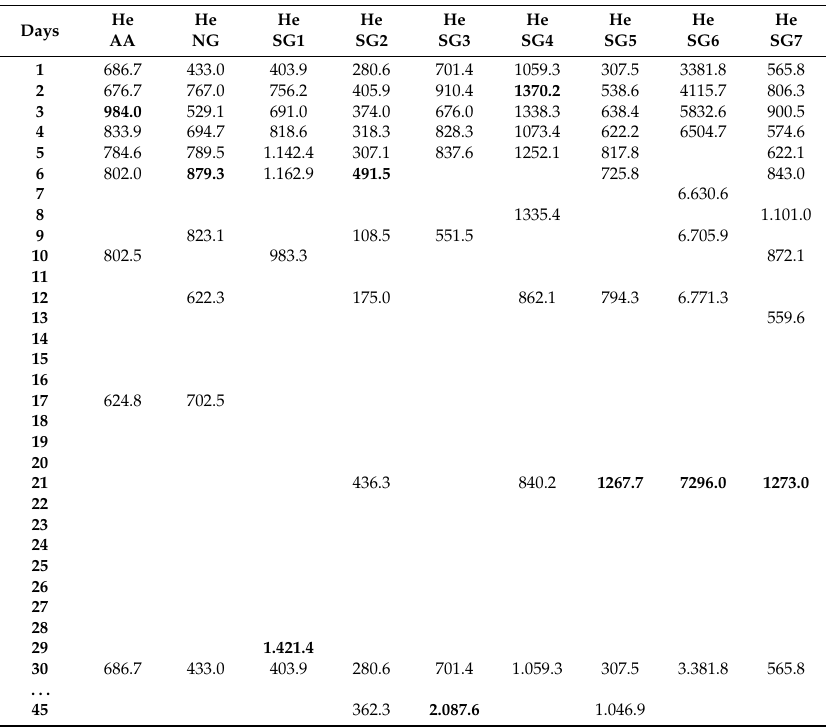
Table A2. Modified Fourier analysis for He in AA, NG and SG 1-7 (4-W samples). Maxima of amplitude are highlighted in bold.